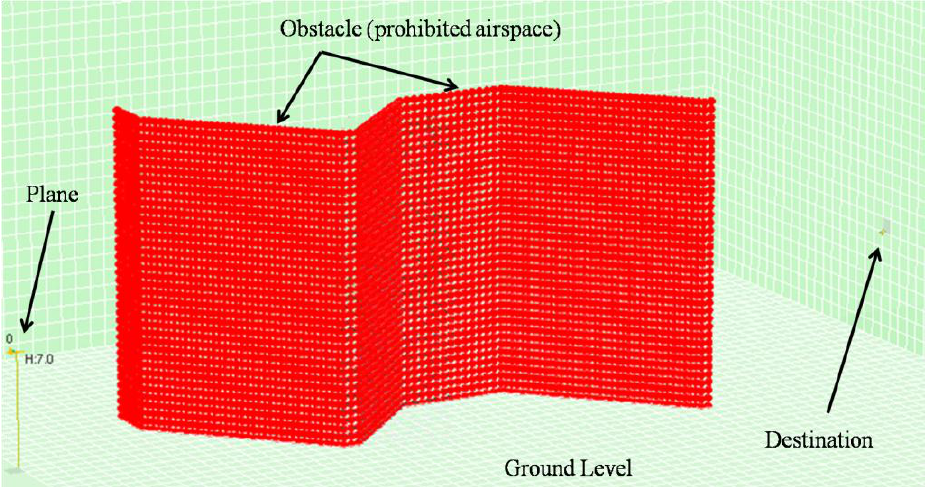
Figure 16. Visualization of the scenario designed in simulation Sim7.